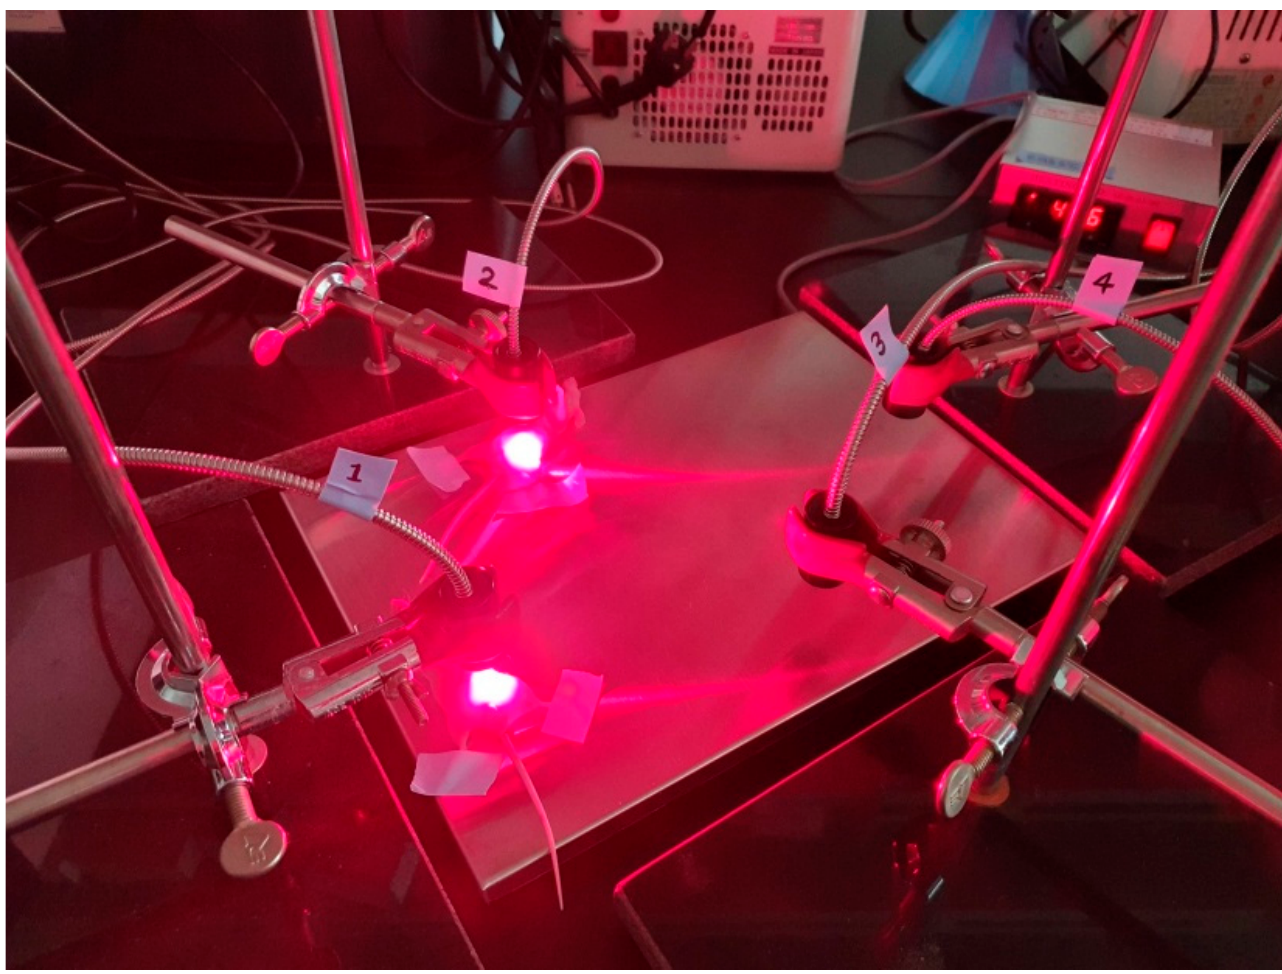
Figure 6. Scene of the in vivo PDT experiment. Tumor-bearing mouse models were established by subcutaneously injecting SCC VII cells to BALB/C nude mice. Three hours after intravenous injection (on day 0 and 7) of 1 mg/kg of photosensitizers, tumors were irradiated (400 mW/cm 2 , 500 s) with the proper wavelength (630 nm for Photofrin and 662 nm for Radachlorin and Photomed) of PDT lasers (on day 0 and 7). Every in vivo irradiation was performed on the heating pad set at 37 ◦ C and under